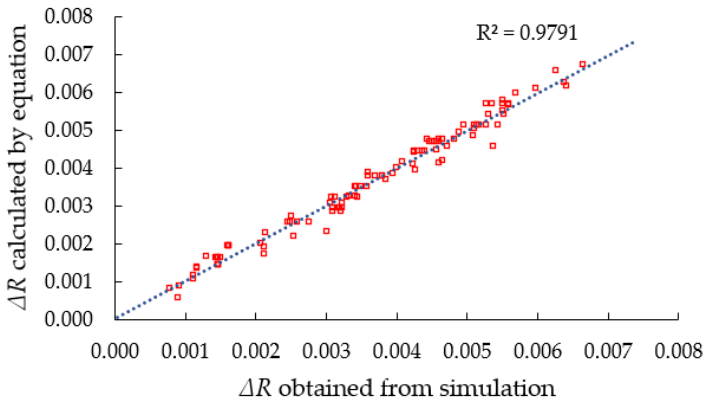
Figure 11. Comparisons between the calculated and simulated results.